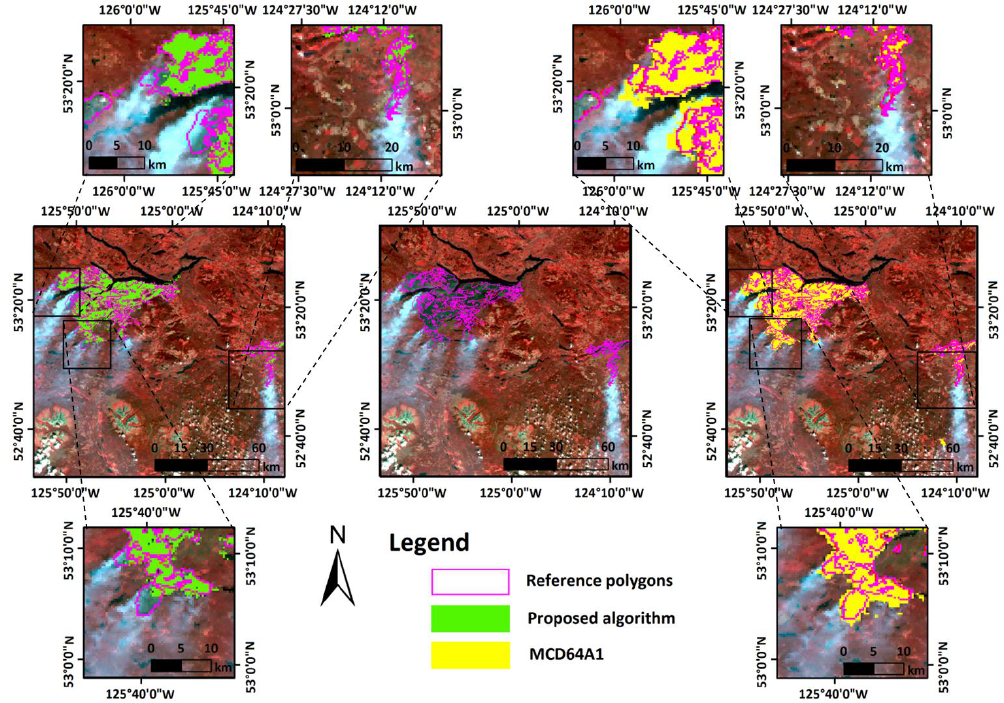
Figure 7. Comparison of burned area results obtained using different methods (study area: Canada).